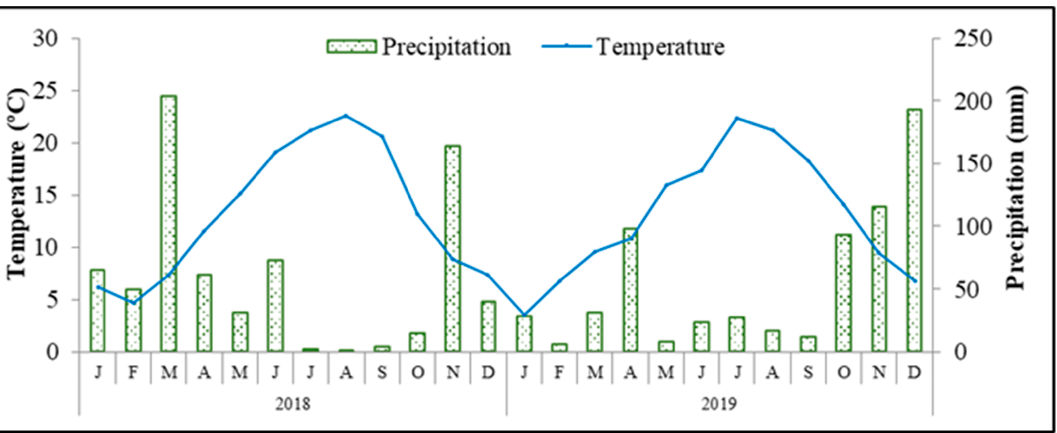
Figure 1. Average monthly temperature and precipitation conditions recorded during the experimental period in the weather station in Paradela, close to the experimental plot. Table 4. Climate characteristics recorded during 2018 and 2019 at the weather station in Paradela, close to the experimental plot. Average annual temperature (Tmean, °C), maximum temperature (Tmax, °C), minimum temperature (Tmin, °C), average temperature (°C) from the blossoming to ripening period (May–October, Tmean (May–October)), cumulative annual precipitation ( Σ Precp., mm) and cumulative precipitation (mm) from the blossoming to ripening period (May–Oct., Σ Precp. (May–October)). Tmean Tmax